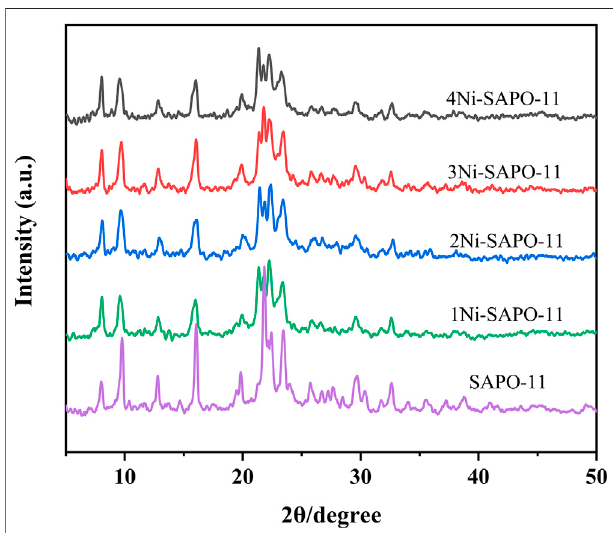
FIGURE 1 | XRD patterns of Ni-modi fi ed SAPO-11 molecular